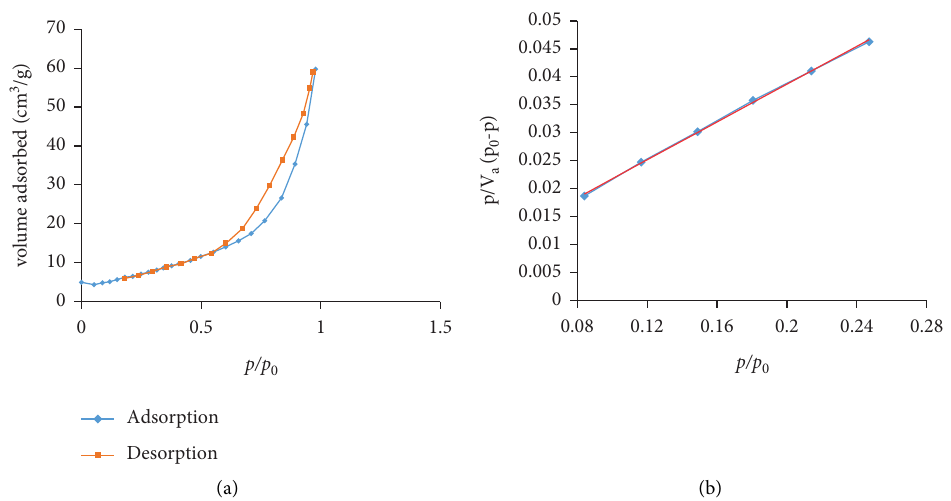
Figure 6: (a) N 2 adsorption-desorption isotherms and (b) BET plot TWMNPs.